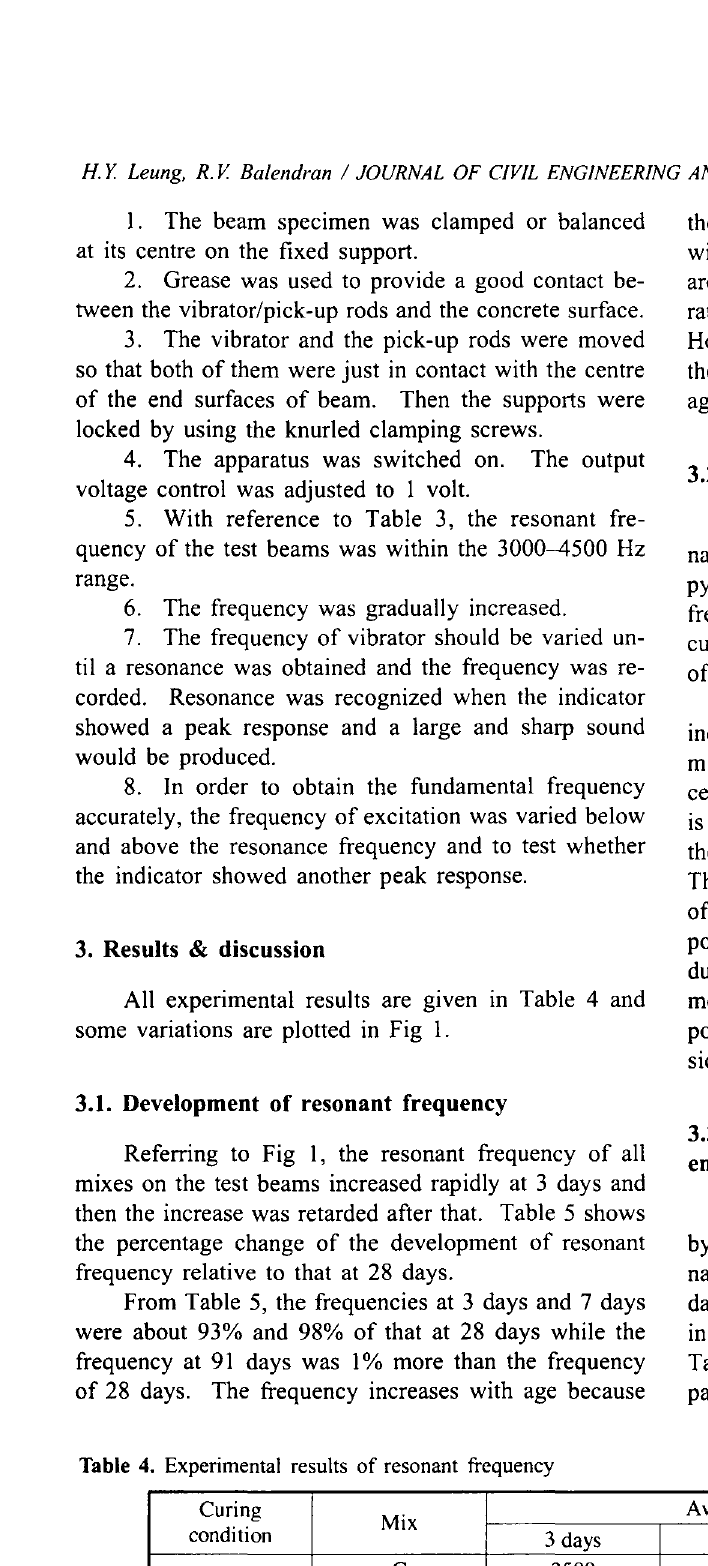
Table 4. Experimental results of resonant